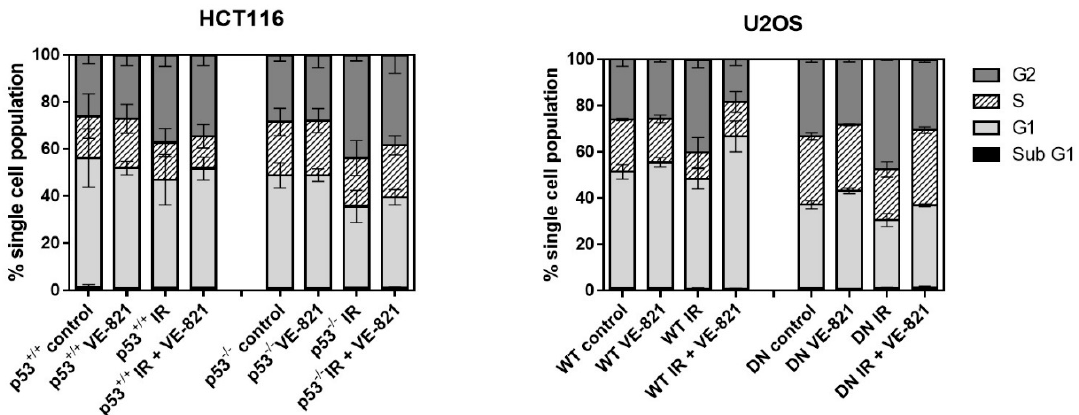
Figure 4. Effect of irradiation and VE-821 on cell cycle distribution of p53 wt and defective cells: Exponentially growing cells treated (where indicated) with 1 µ M VE-821 for 1 h before IR (2 Grays) or mock treatment and the cell cycle distribution determined 24 h later. (Data are mean ± S.D. of three individual experiments).